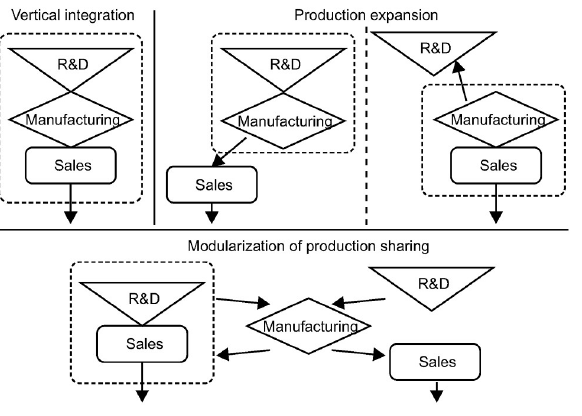
Fig 3. Value chain organization models of Taiwanese OTC electronic information enterprises in Mainland China.